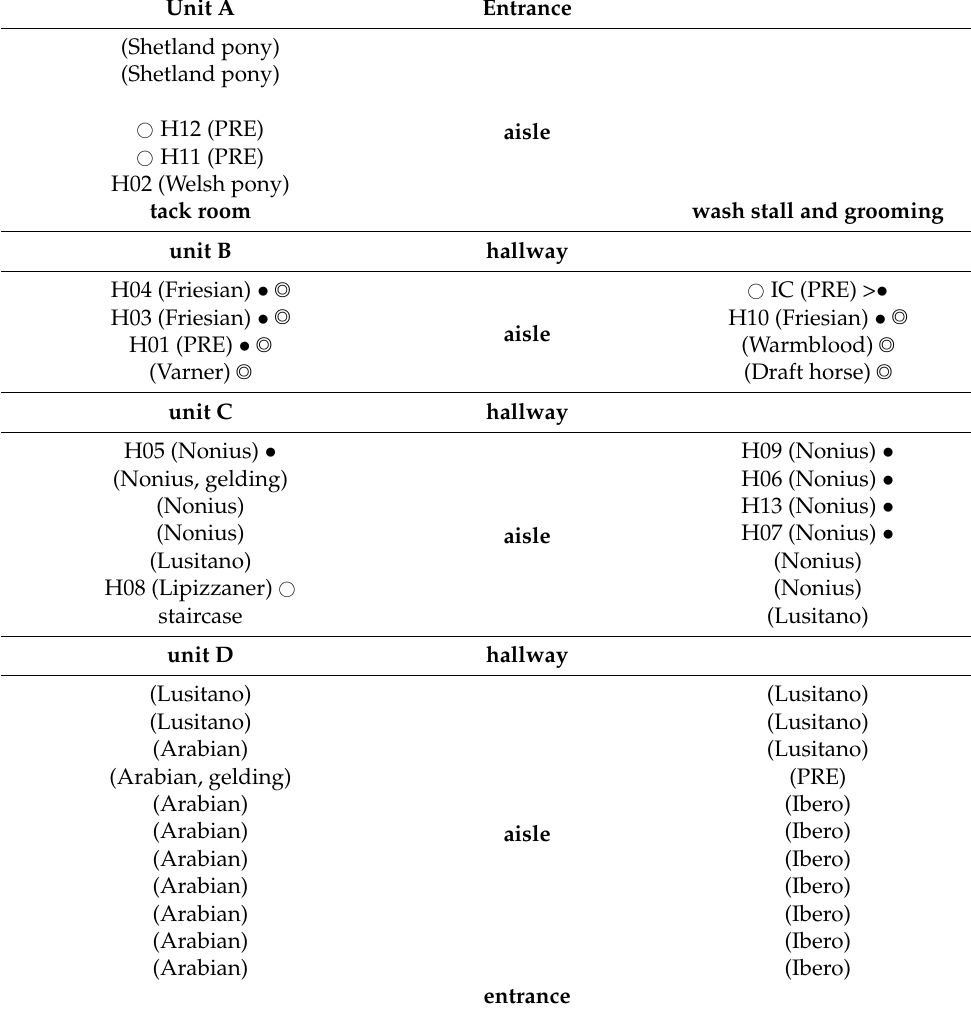
Table 1. Floor plan of stabled horses and ponies at the facility, all males were intact, except where indicated as ‘gelding’, and spread over four subunits (A–D). In yellow: horses with clinical signs; in green: additional serum samples for the anti-EAV antibody titer (virus neutralization VN); see Table 1. Symbols: